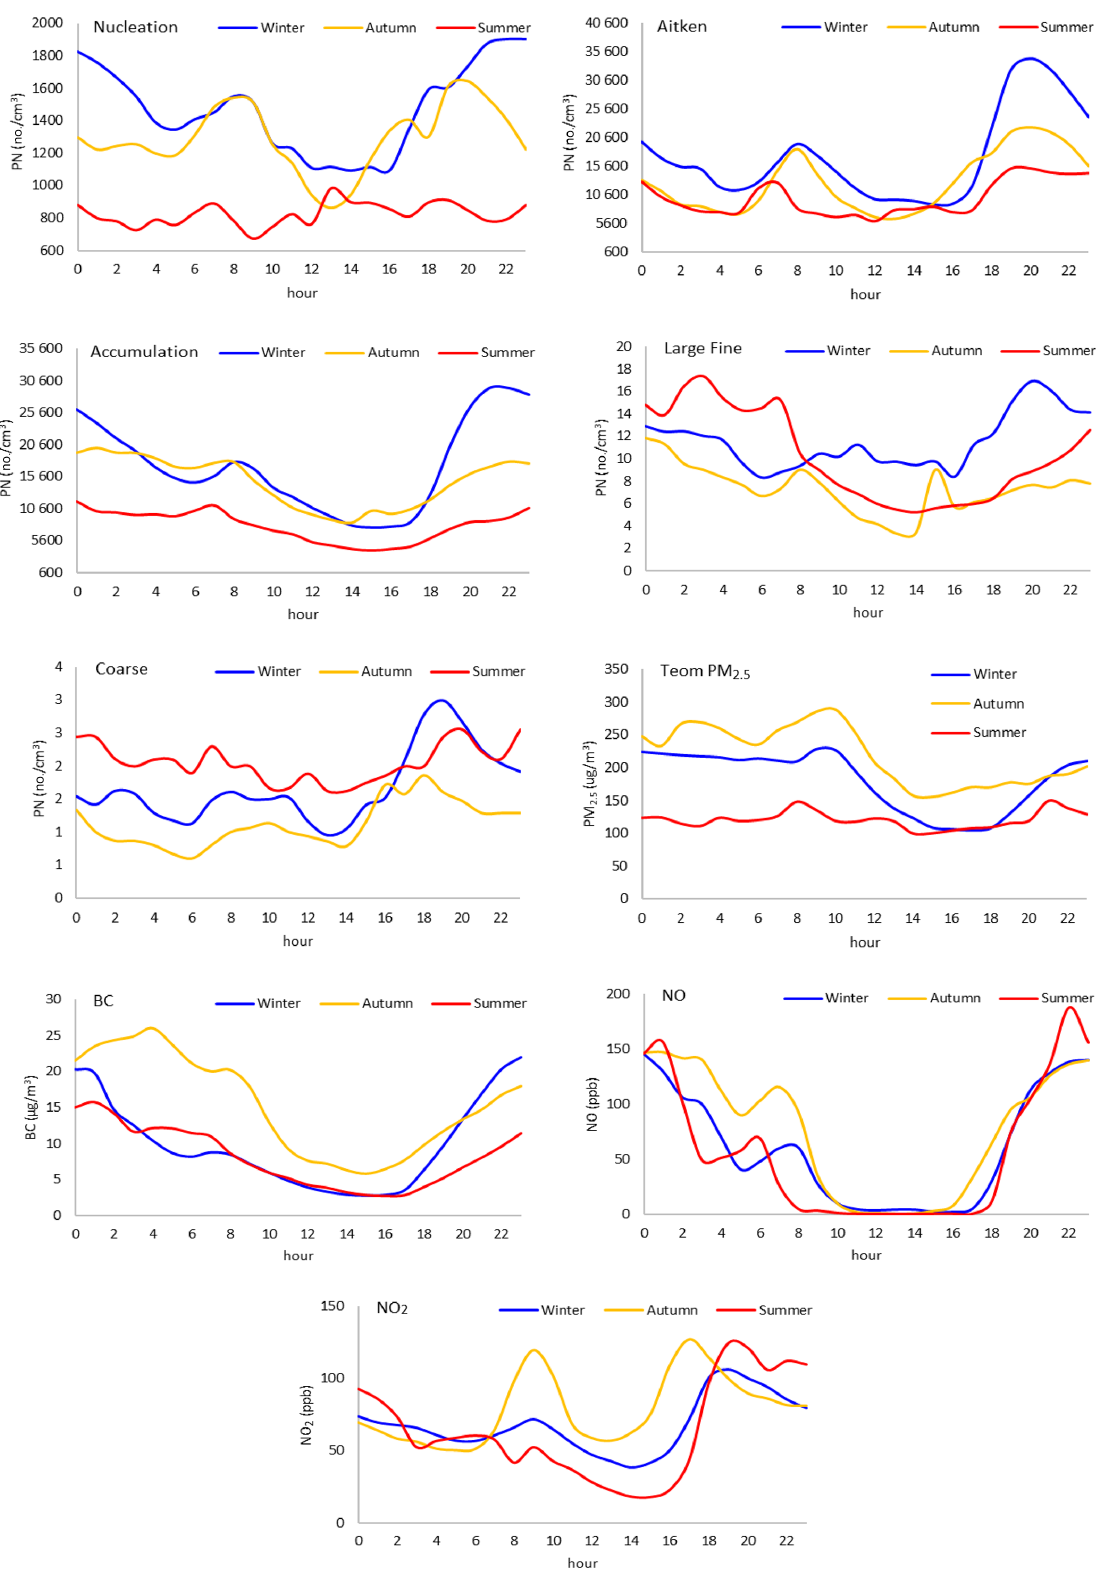
Figure 2. Average diurnal variation in particle number counts for nucleation, Aitken, accumulation, large fine, and coarse modes and PM 2 . 5 , BC, NO, and NO 2 in autumn, summer, and